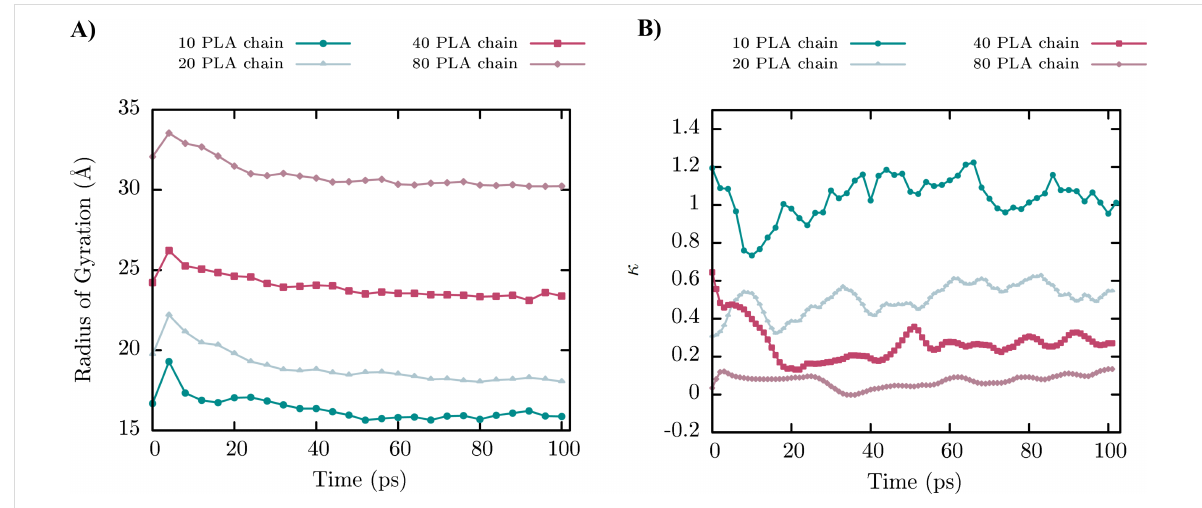
Figure 7: A) The radius of gyration and B) triaxial parameter as a function of simulated time for PLA cores with a different number of PLA chains (10, 20, 40 and 80).